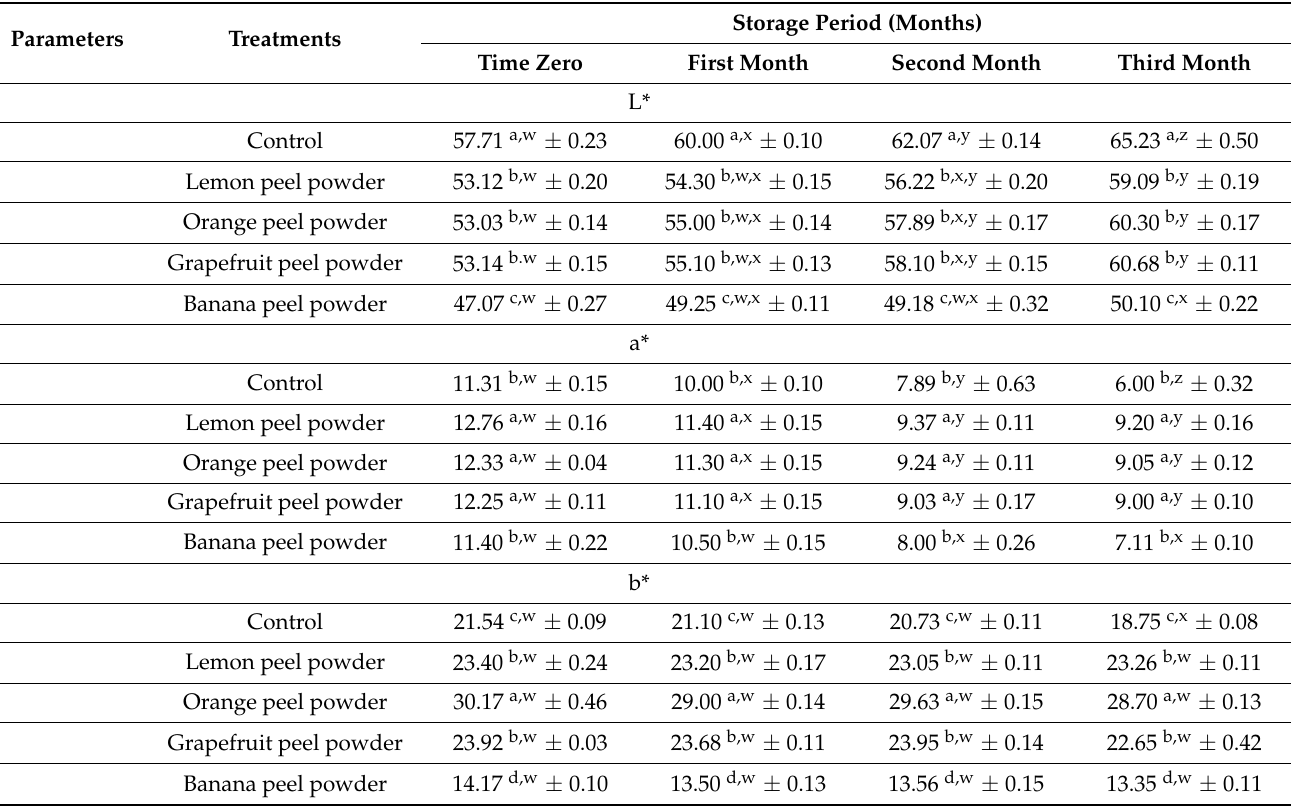
Table 4. Color values of chicken patties with the incorporation of different fruit peel powders (1%) during frozen storage ( − 18 ◦ C) for 3